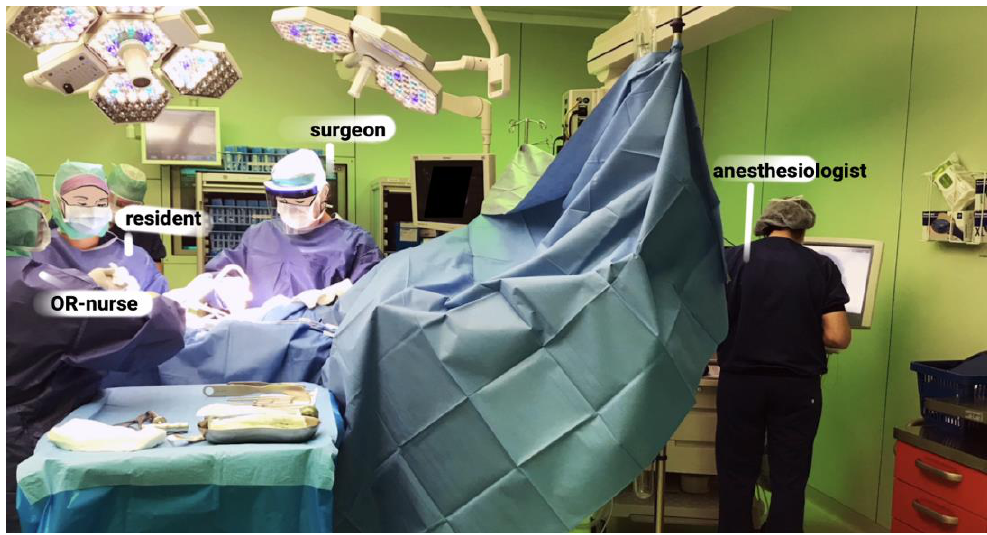
Figure 1. The setting of an orthopaedic